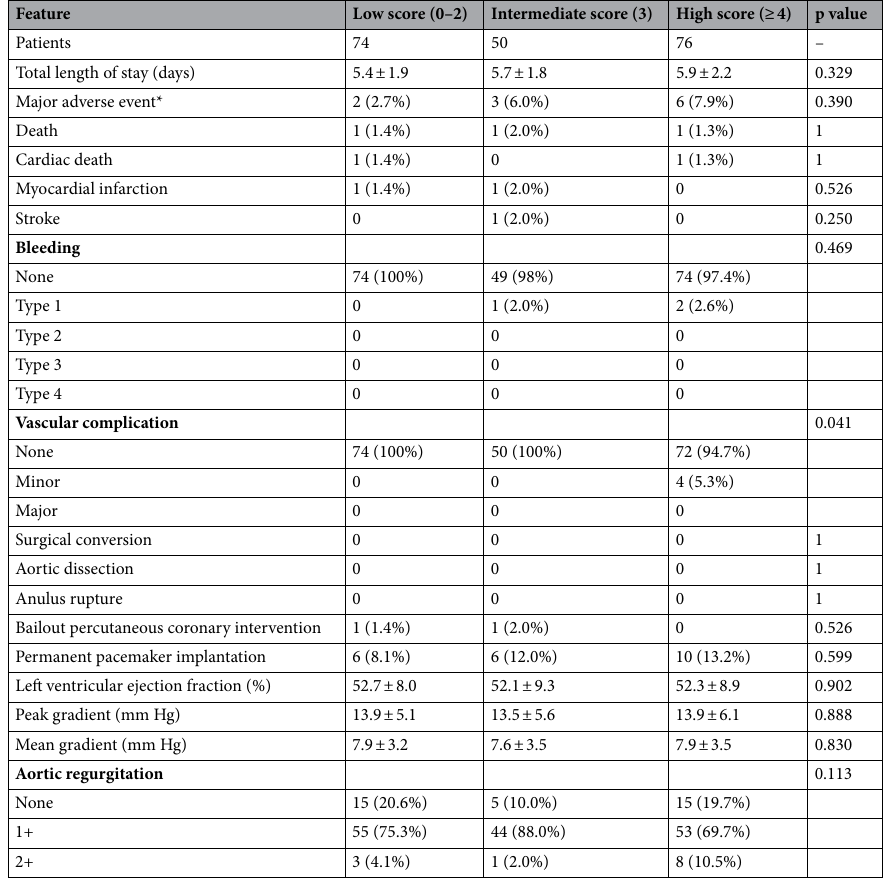
Table 4. Clinical and imaging outcomes at 1-month follow-up according to TAVI-CT (transcatheter aortic valve implantation-computed tomography) score. *Composite of death, myocardial infarction, stroke, bleeding, or vascular